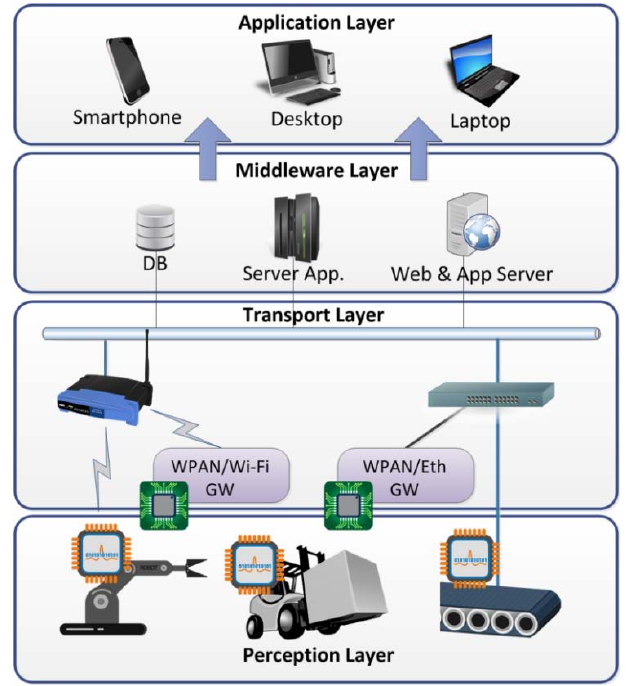
Figure 1. Five-layered architecture of the working environment monitoring system.